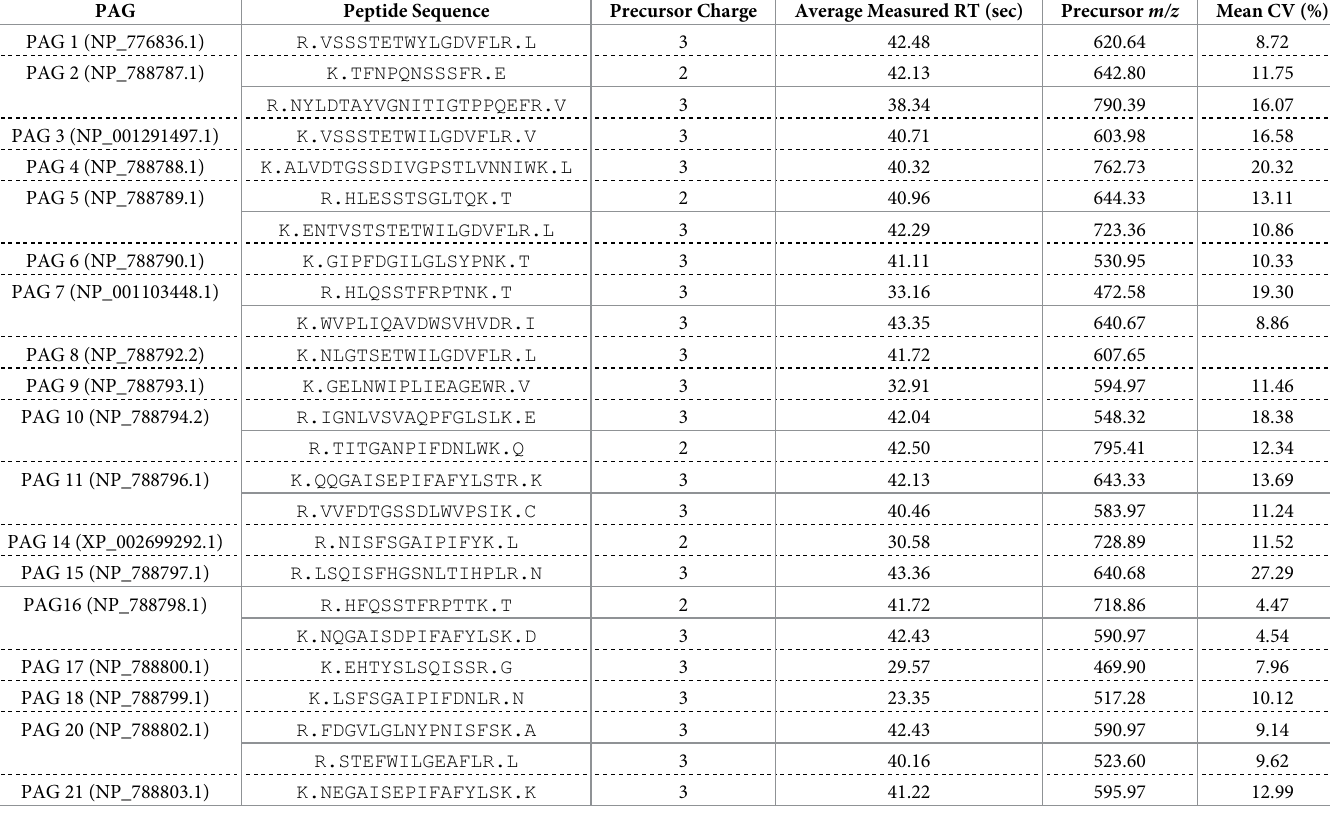
Table 1. List of proteins and proteotypic peptides. PAG Peptide